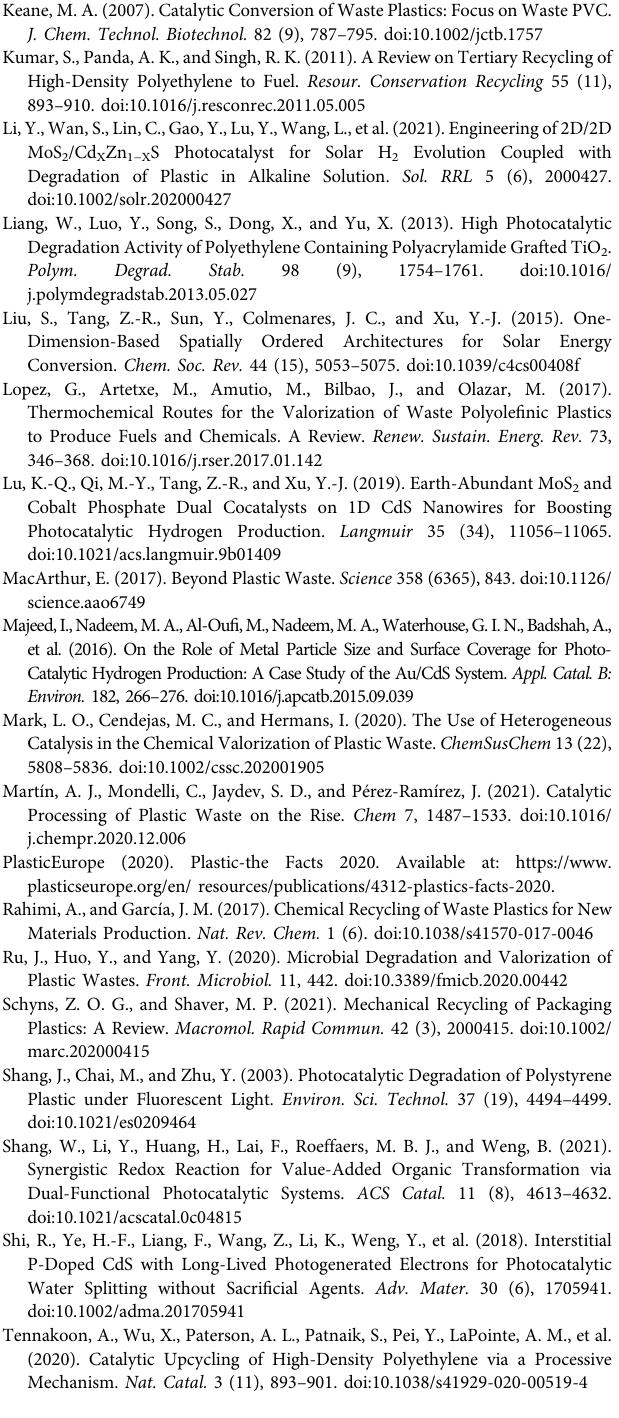
Supplementary Figure 5 | (A) Structure of the V-based photocatalyst; (B) the conversionschemeofPEovertheVcatalysts; (C) proposedreactionmechanismfor the cascade C-C bond cleavage in polyethylene-monoalcohol. The bonds that undergocleavagearehighlightedinboldandred.Conditions:whiteLEDs,85 ° C.The fi gure is reprinted with permission from Gazi et al. (2019), copyright 2019, Wiley. Supplementary Figure 6 | (A) Schematic illustration for converting various waste plastic into C 2 fuels by a designed sequential pathway under simulated natural